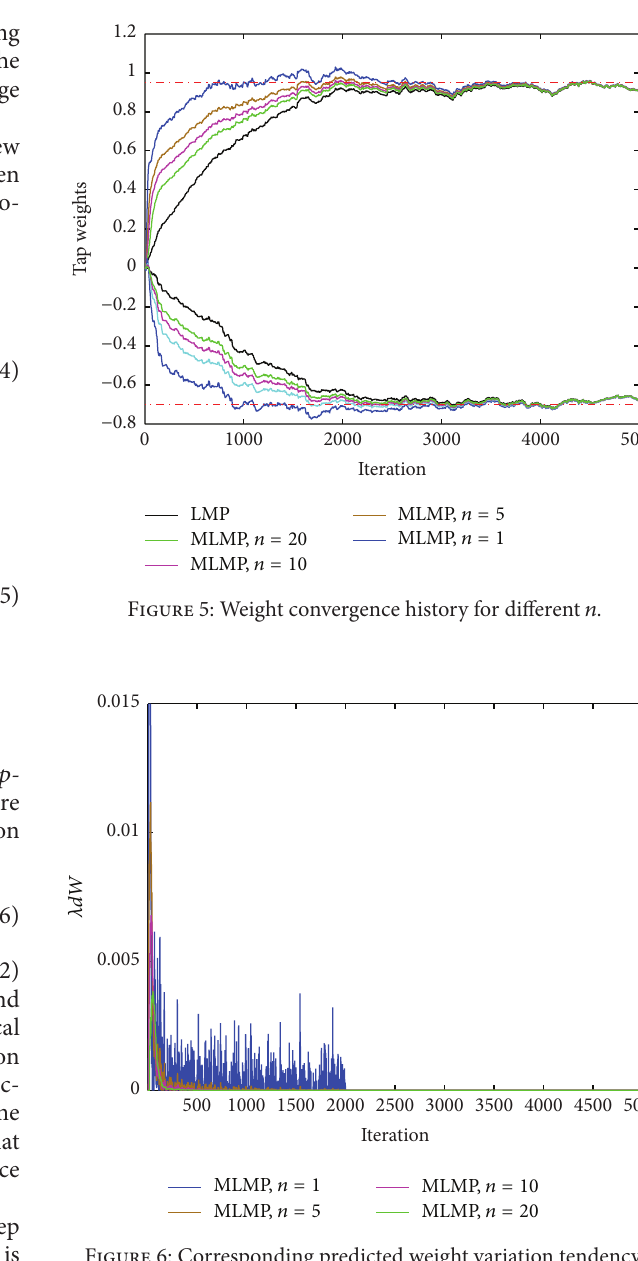
Figure 6: Corresponding predicted weight variation